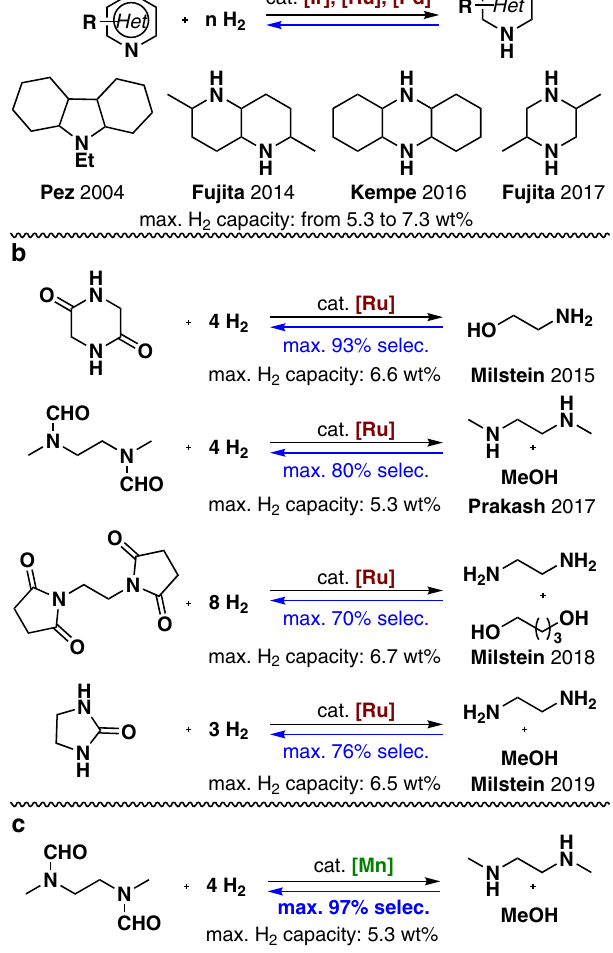
Fig. 1 Hydrogen storage systems based on N -containing organic hydrides. a Heterocycles hydrogenation and dehydrogenation reactions. b Amide bond formation and Hydrogenation reactions. c Mn-catalyzed hydrogenation and dehydrogenation